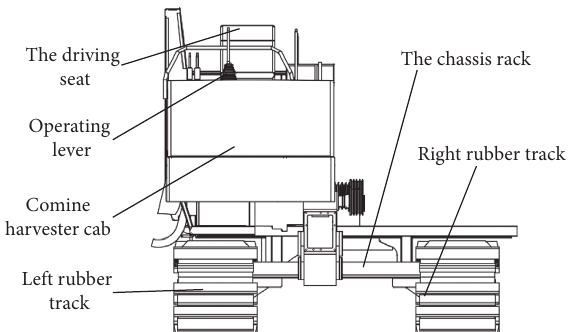
Figure 1: Schematic diagram of crawler chassis of rice combine harvester.